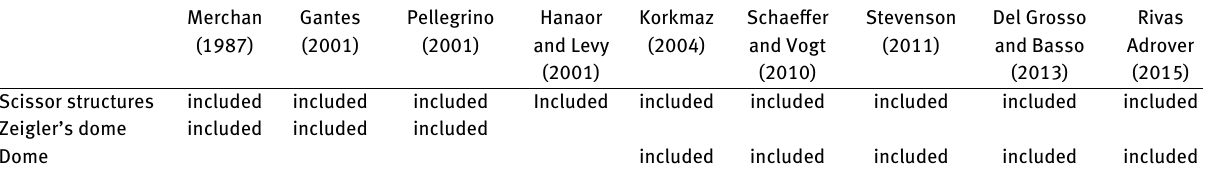
Table 2: Inclusion of the scissor structures, Zegiler’s dome and dome in the general sense in the classifications over the